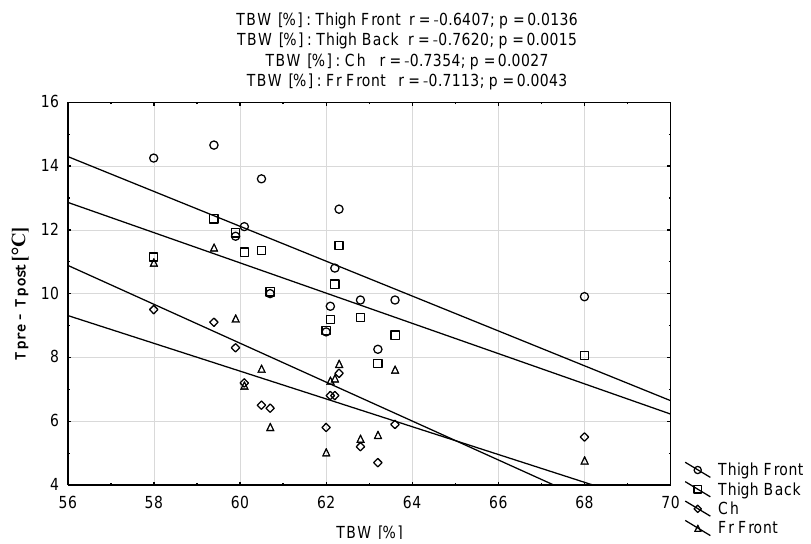
Figure 10. Relationship between %TBW and the magnitude of change in temperature of the anterior and posterior surfaces of the thighs, chest, and forearm front. Legend : Fr — forearm; Ch — chest.